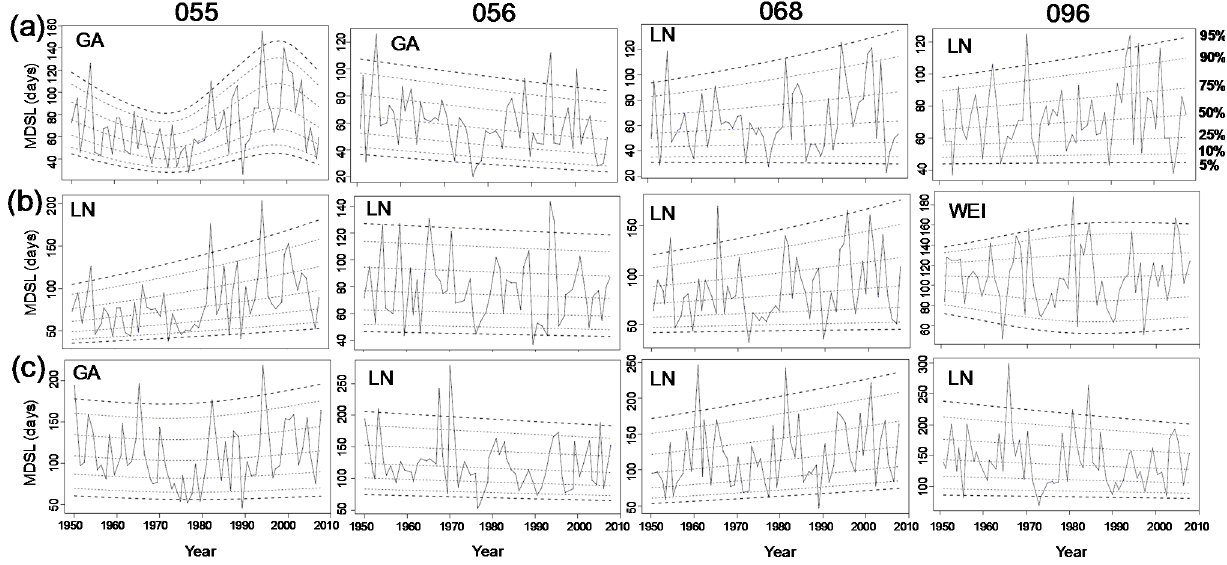
Figure 4. GAMLSS applied to MDSL (days) in the headbasin of the Segura River at grid sites 55, 56, 68, and 96 for thresholds: ( a ) 1 mm/day; ( b ) 5 mm/day; ( c ) 10